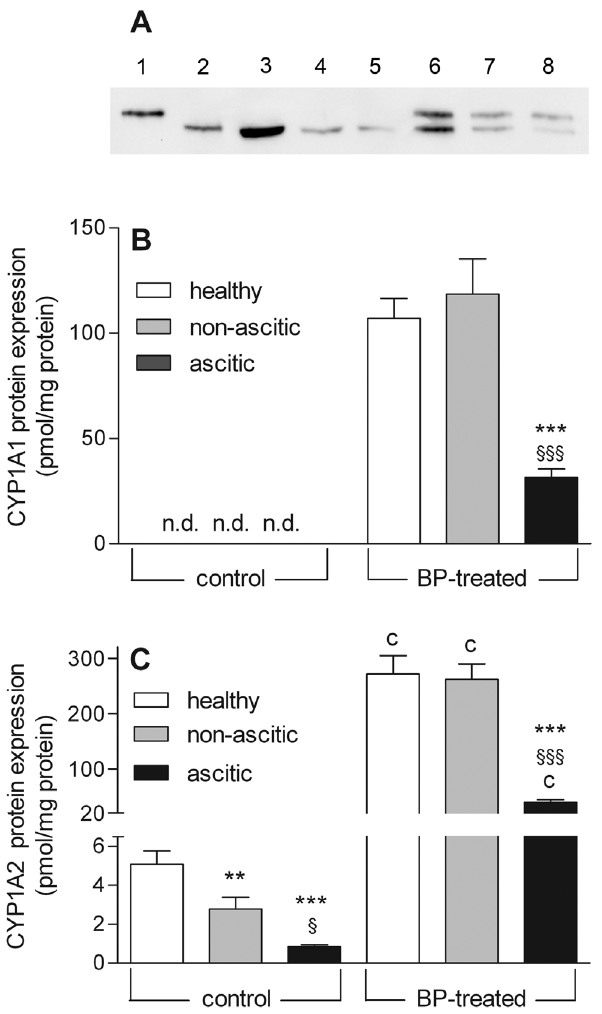
Figure 5. AhR gene transcription levels and protein expression in control and BP-treated rats. (A) Experimental data showing AhR mRNA levels are reported as fold variation compared with healthy control rats. (B) Representative Western blots showing the separation of total liver protein extracts obtained from control and BP-treated rats. The amounts of proteins loaded per lane were 60 m g. The ticks indicating 105 and 43 KDa correspond to the AhR and b -actin bands, respectively. Lanes 1 to 3: healthy, non-ascitic and ascitic control rats; lanes 4 to 6: healthy, non-ascitic and ascitic BP-treated rats. (C) Amount of AhR protein in livers from control and BP-treated rats normalized to the signal intensity of the corresponding b -actin band and shown as fold variation compared with healthy control rats. All results are means 6 S.E. of data obtained from 8 rats per group. **P , 0.01 vs. healthy rats. 1 P , 0.05, 11 P , 0.01 vs. non-ascitic cirrhotic rats. a P , 0.05, b P , 0.01, c P , 0.001 vs. control rats of the same group.